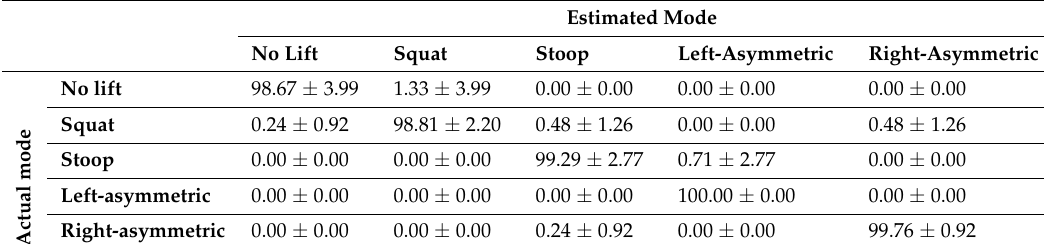
Table 3. Confusion matrix (Mean ± STD) for subject-independent recognition